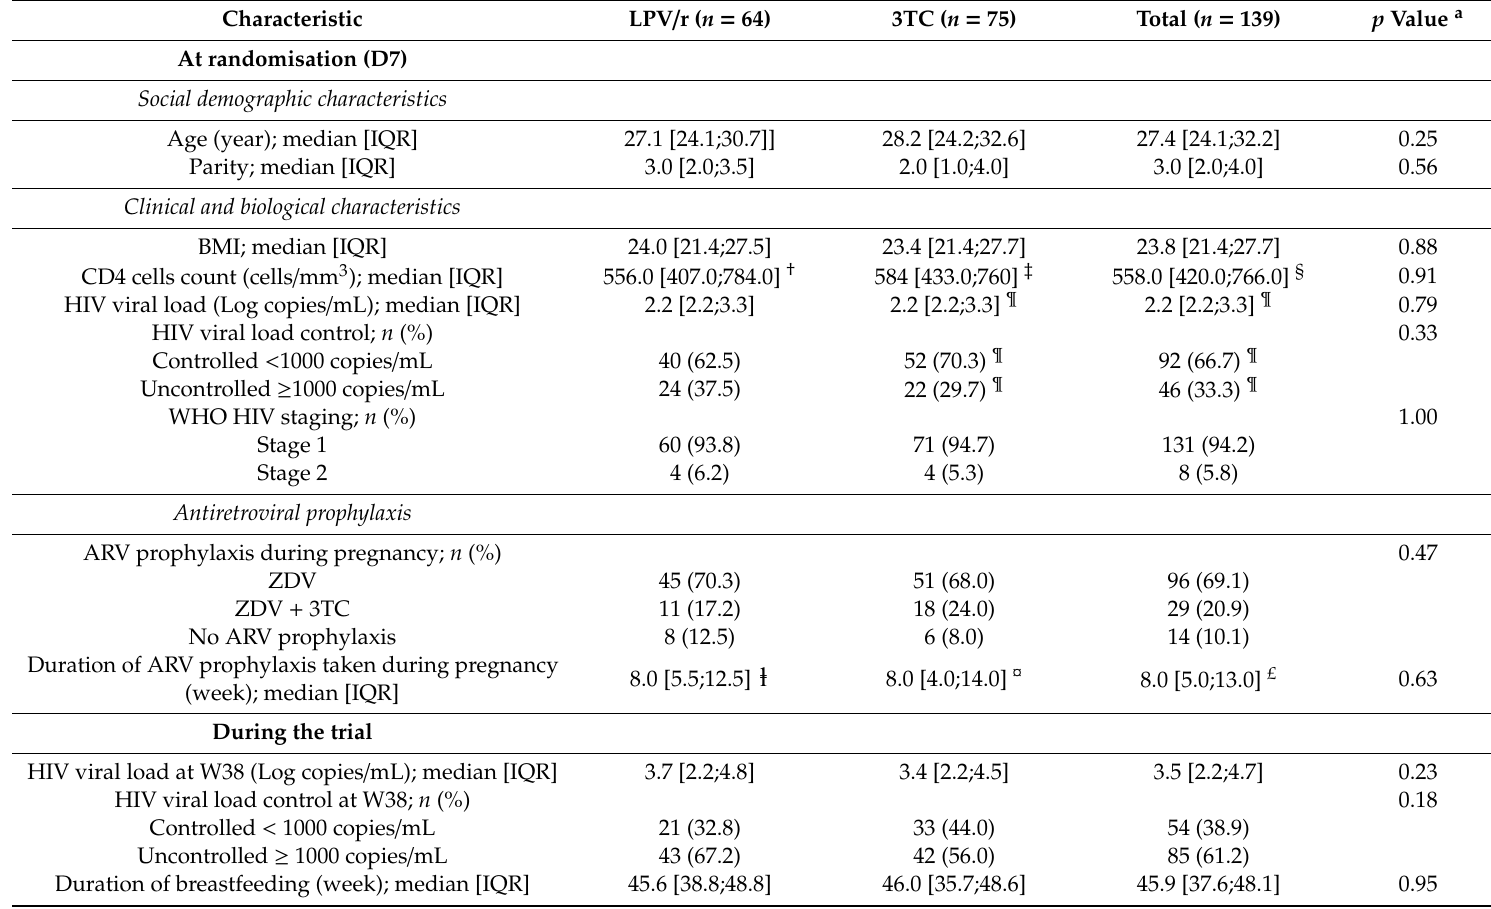
Table 2. Maternal characteristics at randomisation (D7) and during follow